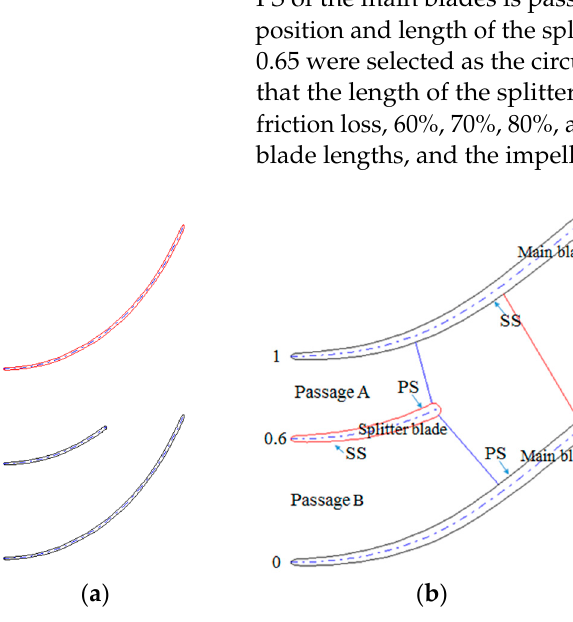
Figure 3. Blade section of impeller: ( a ) Shroud blade section; ( b ) mid-span blade section; ( c ) hub blade section.